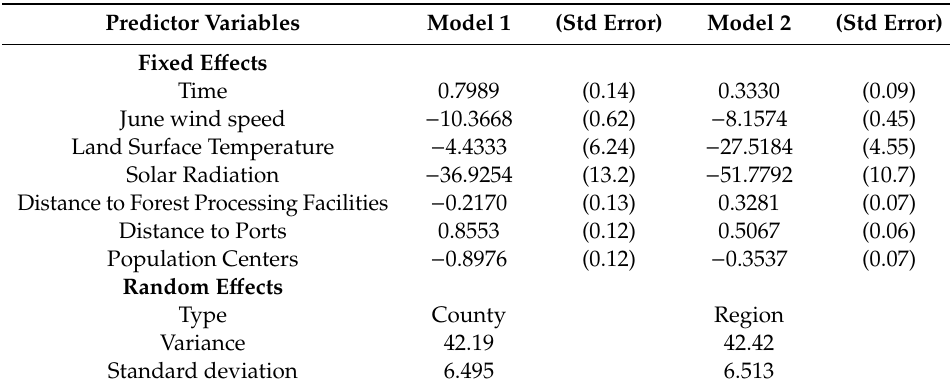
Table 6. Estimation results for fixed e ff ects and random e ff ects by the generalized linear mixed model with the logistic link function. Model 1 stands for the GLMM with county random e ff ect; model 2 stands for the GLMM with regional random e ff ect.